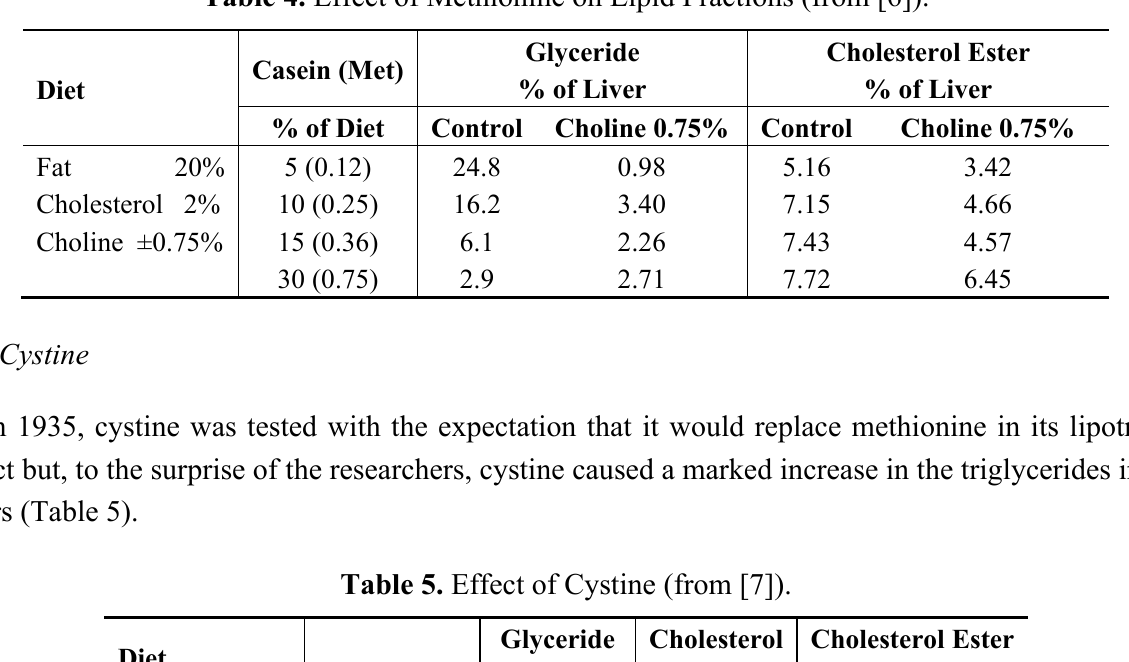
Table 4. Effect of Methionine on Lipid Fractions (from [6]).